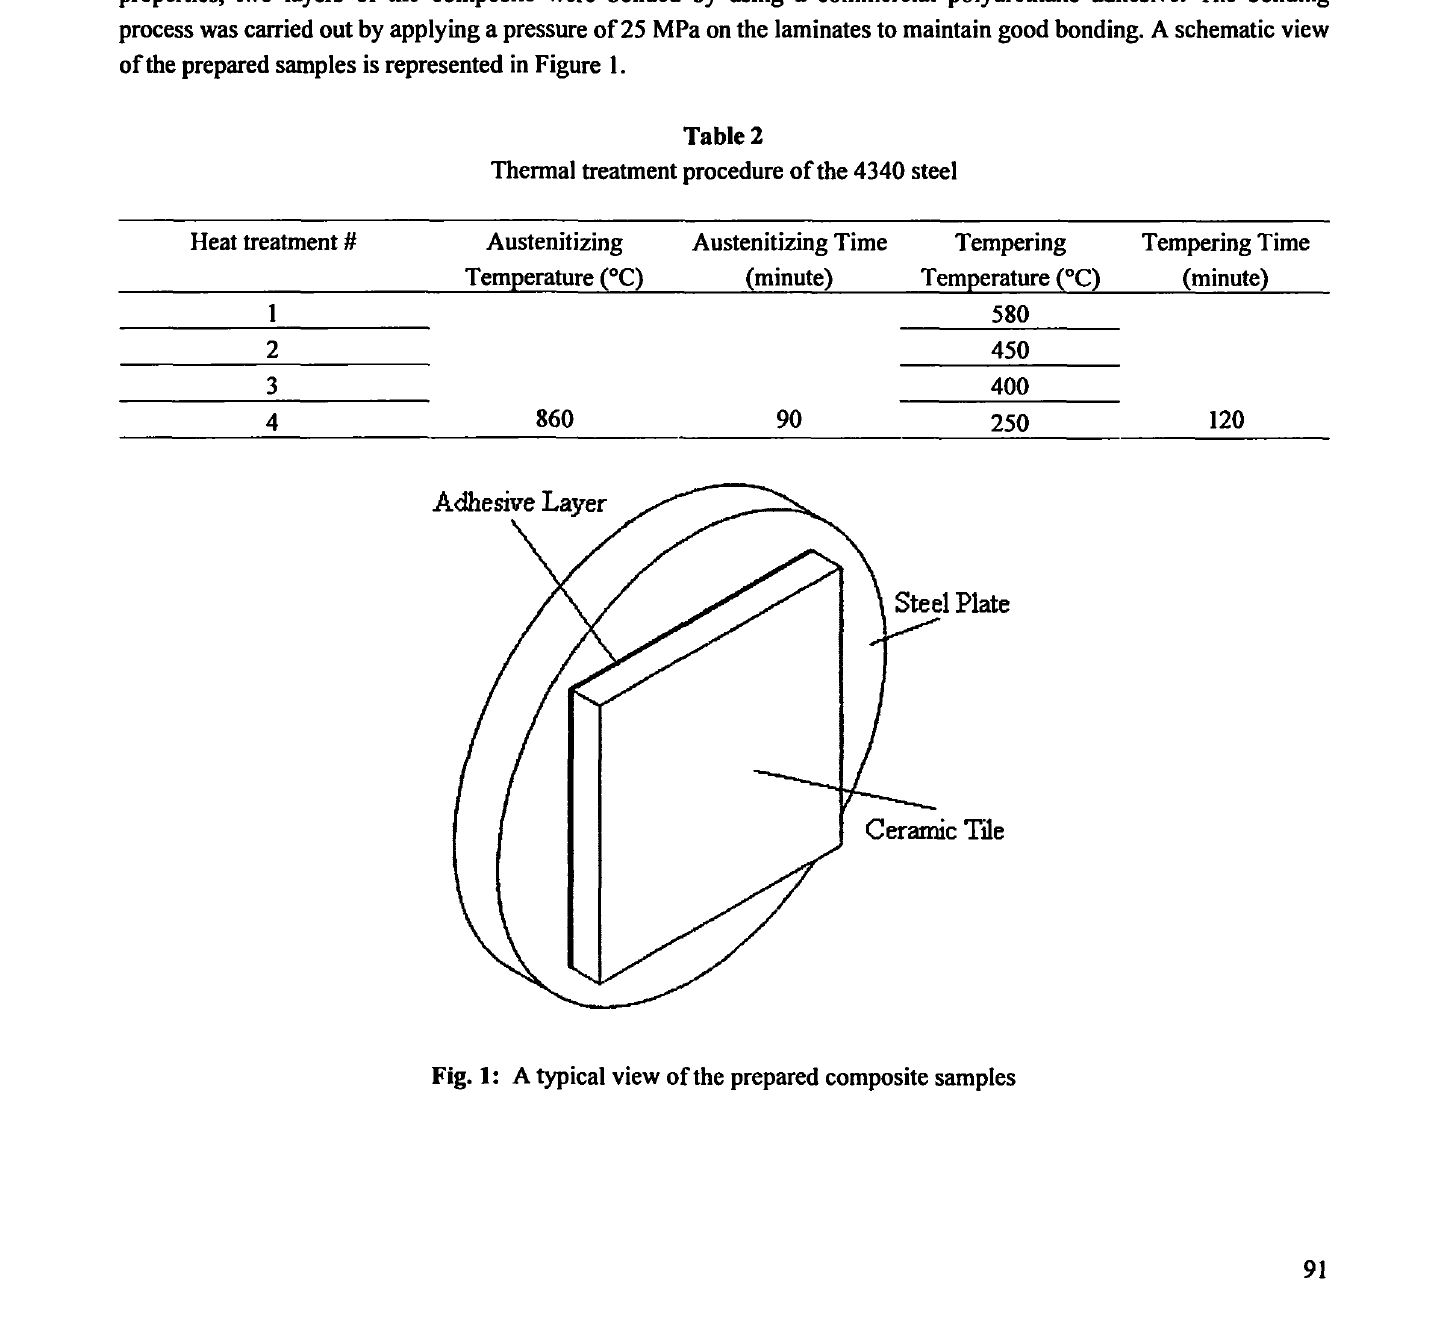
Fig. 1: A typical view of the prepared composite